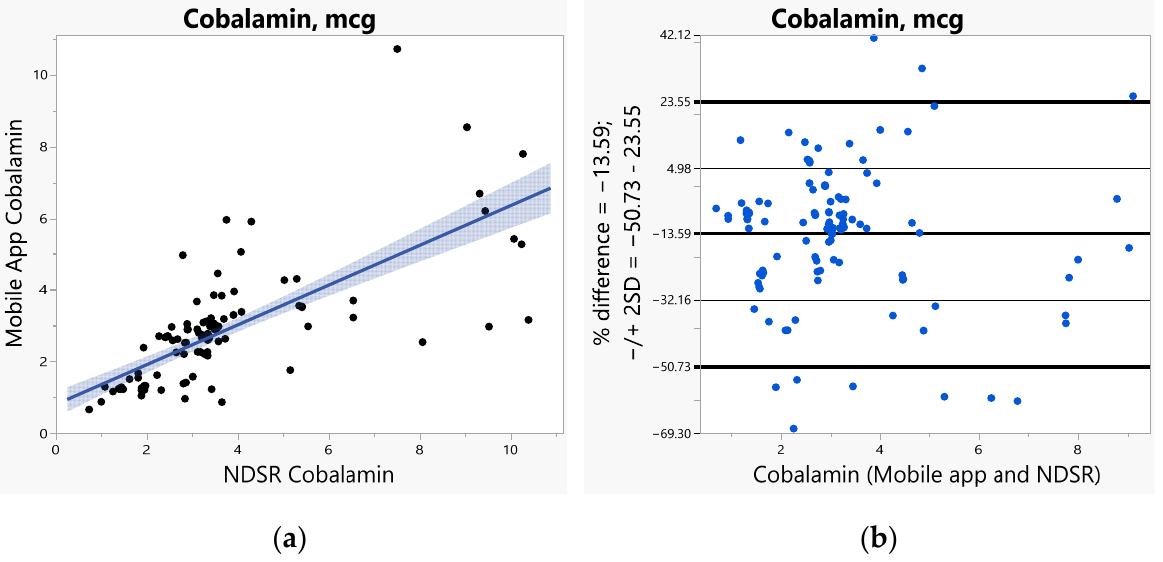
Figure 4. ( a ) Correlation, ( b ) Bland-Altman plots between the internet-based application and Nutri- tion Data System for Research (NDSR) on cobalamin.